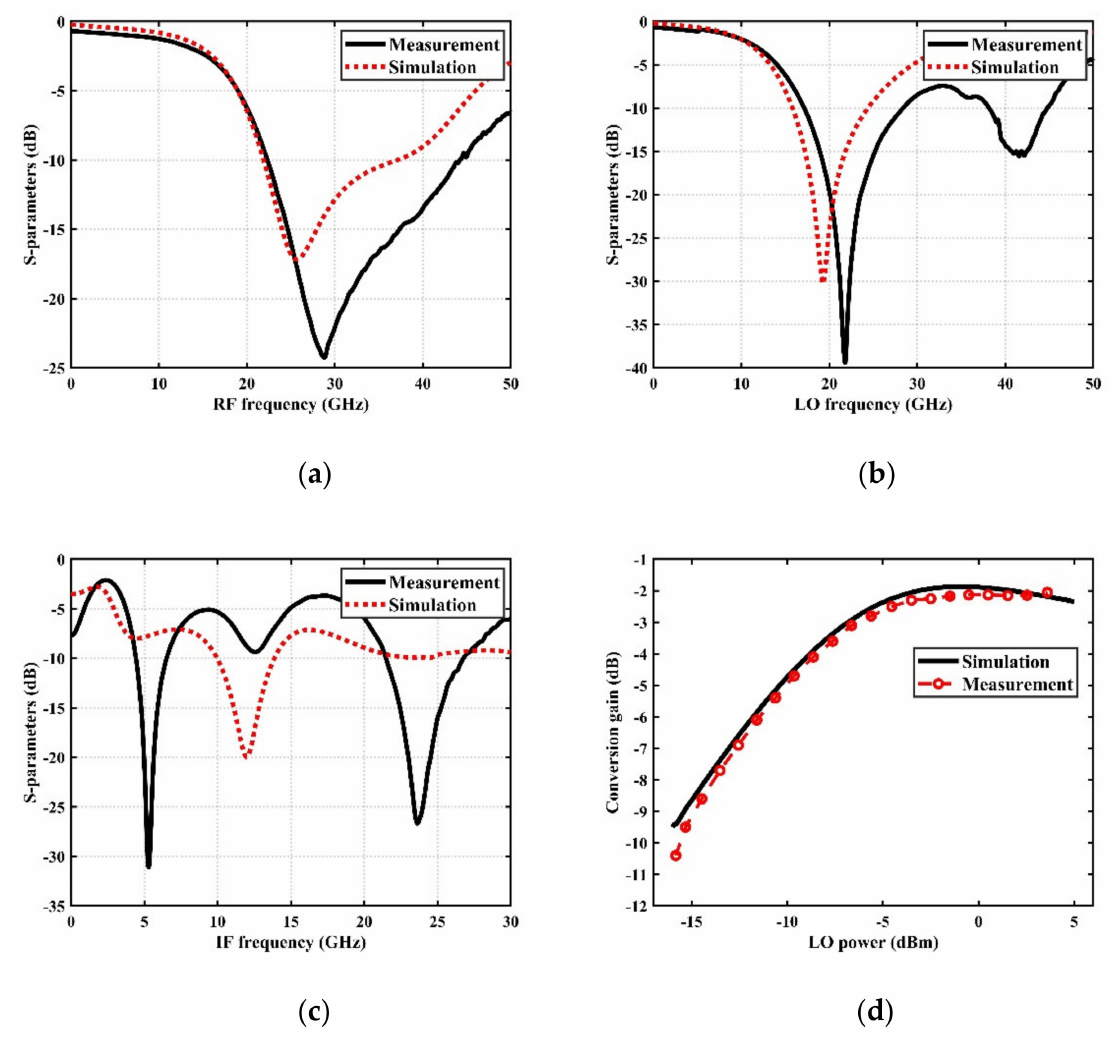
Figure 16. Simulated and measured return losses of ( a ) RF port (S 11 ), ( b ) LO port (S 22 ) and ( c ) IF port (S 33 ). ( d ) Simulated and measured CG versus LO power while RF frequency and LO frequency are 27 GHz and 20 GHz,